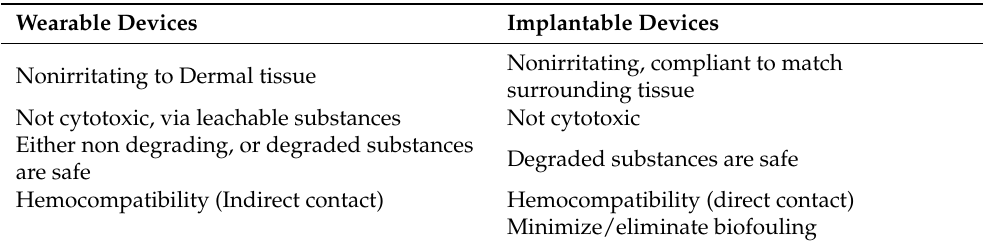
Table 1. A table comparing the biocompatibility requirements (ISO 10993) for both implanted and wearable devices